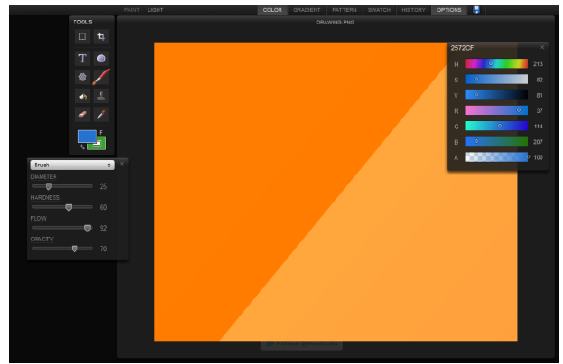
Fig. 3. Web-browser Sketchpad developed on the basis of HTML5, CSS3,